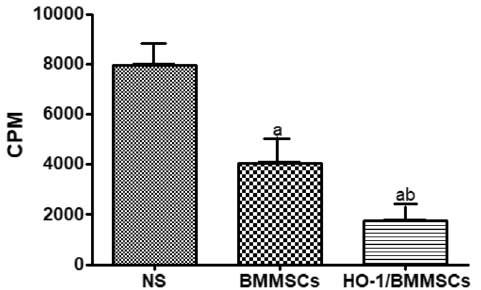
Figure 2. Differences in MLR between recipient treatment groups. The HO-1/BMMSC group compared with the BMMSC group ( b P < 0.05). The BMMSC group compared with the NS group ( a P < 0.05). The HO-1/BMMSC group compared with the NS group ( ab P < 0.05).